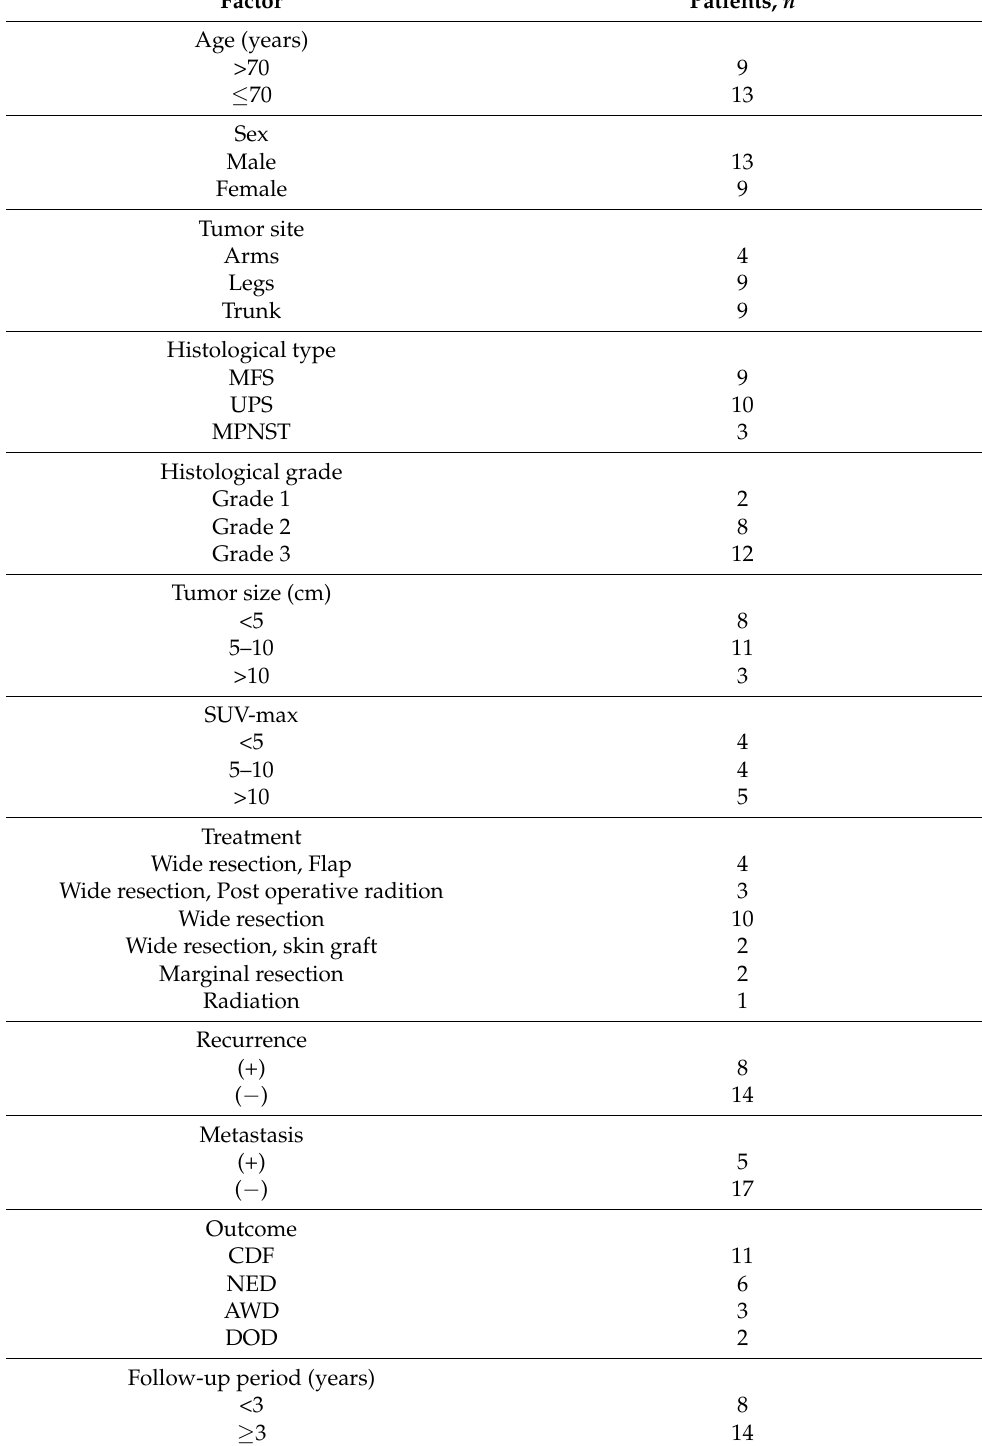
Table 3. Characteristics of the study